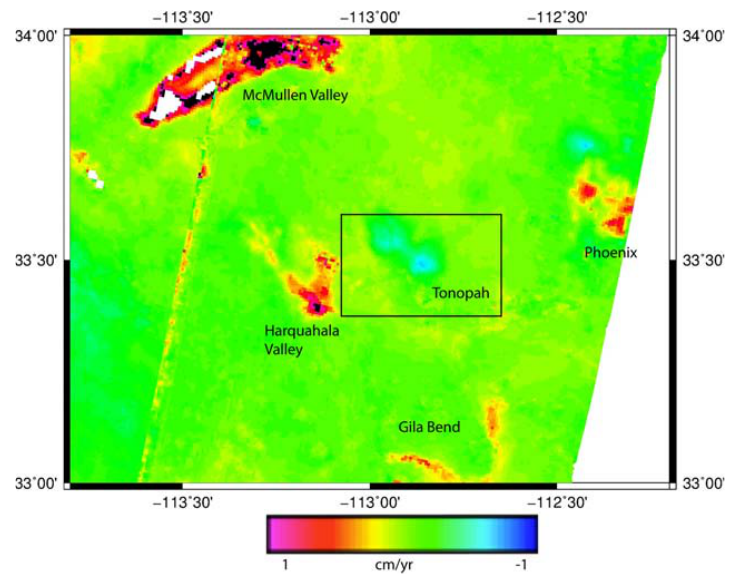
Figure 10. Unwrapped Envisat interferogram spanning 21 May 2005 to 8 August 2009, showing areas of ground deformation in Arizona that are primarily subsiding, with the uplifting region in the box near Tonopah, AZ, shown in Figure 11.